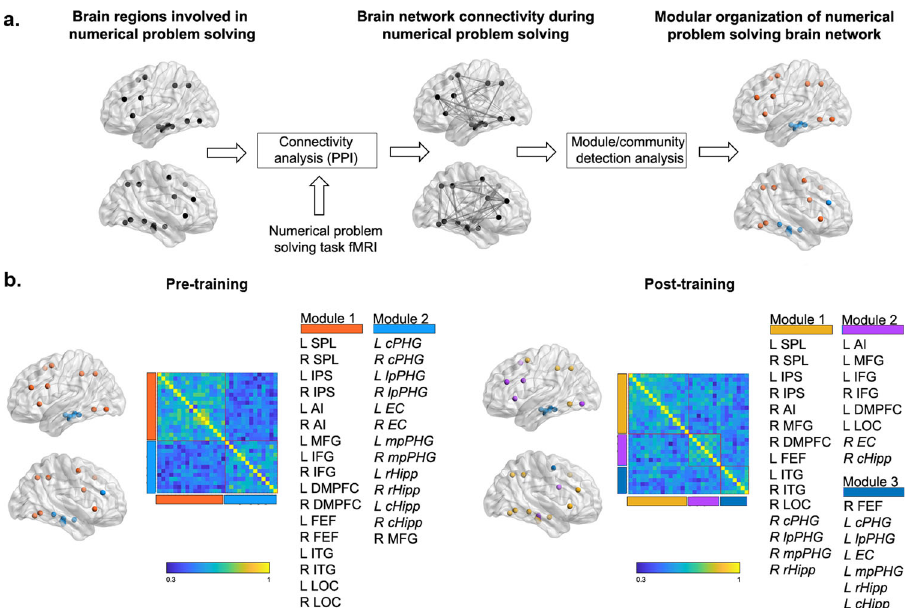
Fig. 3 Cognitive training induces changes in modular brain network organization. a Overall analytical pipeline to compute and compare modularity of brain network organization before and after training. Meta-analysis was used to identify parietal, frontal, and ventral temporal-occipital regions consistently activated during numerical problem solving, in addition to hippocampus and parahippocampal gyrus subregions within the medial temporal lobe (MTL). We constructed brain network models using task-evoked measures of functional connectivity (estimated by Addition vs. Control condition) between these brain regions and used community detection analysis to investigate network organization before and after training. b Graph-based analysis revealed distinct patterns of modular network organization before and after cognitive training. Speci fi cally, group-averaged task-related brain networks, as shown in connectivity matrices, were characterized by the presence of two modules prior to training and three modules after training. Before training, the fi rst module (Module 1) consisted of parietal, frontal, and ventral temporal-occipital regions, while the second module (Module 2) comprised all MTL regions, including the hippocampus and parahippocampus bilaterally, and the right medial frontal gyrus (MFG). After training, individual functional subregions of the MTL formed a more complex three-module structure with parietal, frontal, and ventral temporal-occipital regions (Modules 1 – 3). N = 35 children. MTL regions are shown in italics. Color bar represents connectivity strength between pairs of nodes. SPL: superior parietal lobule; IPS: intraparietal sulcus; AI: anterior insula; IFG: inferior frontal gyrus; DMPFC: dorsomedial prefrontal cortex; FEF: frontal eye fi eld; ITG: inferior temporal gyrus; LOC: lateral occipital cortex; cPHG: caudal parahippocampal gyrus; lpPHG: lateral posterior parahippocampal gyrus; EC: entorhinal cortex; mpPHG: middle posterior parahippocampal gyrus; rHipp: rostral hippocampus; cHipp: caudal hippocampus. L: left; R: